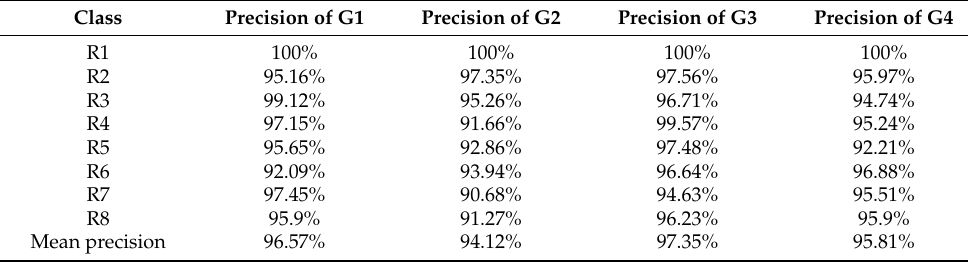
Table 7. Prediction precision of DCNN–SVM for collision localization in Case 2.